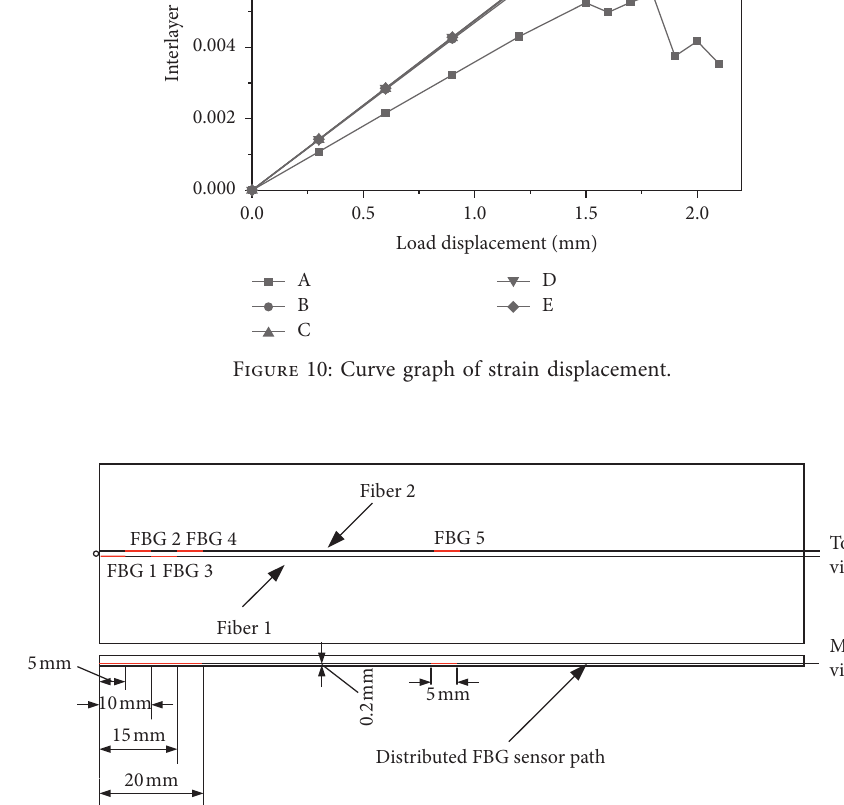
Figure 11: Embedded location of FBG